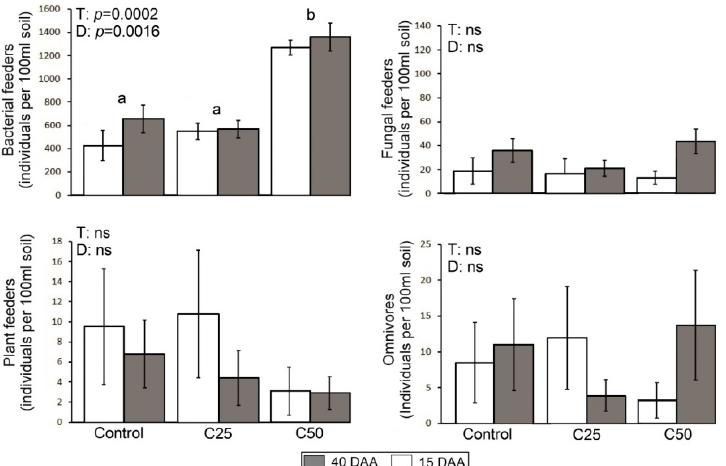
4 of 15 Figure 2. Mean values (± st. error) of soil enzyme activities and results of PERMANOVA regarding the effect of “treatment” (T), “duration of treatment” (D) on these parameters. Different letters (a, b, c) indicate significant differences of pairwise comparisons among treatments (Control, C 25 and C 50 ). 2.3. Effects of Whey on Nematode Bio-Communities Regarding nematodes, four different trophic groups were found in the samples, namely fungal feeders, bacterial feeders, omnivores and plant feeders. We did not find any predatory nematodes. Bacterial feeding nematodes abundance (Figure 3) was the only trophic group that was significantly